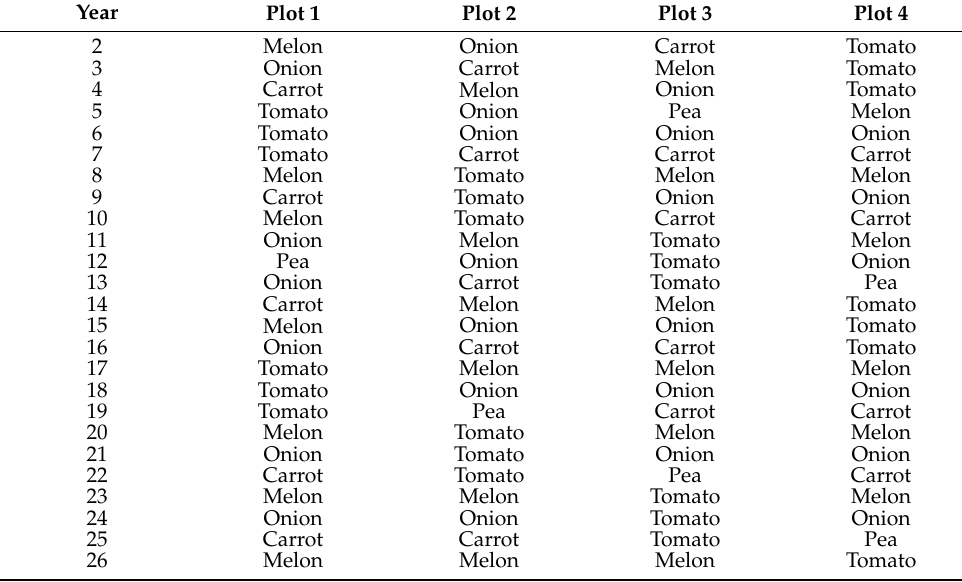
Table A1. Processing-tomato rotation scheduling for 25-year lifespan.